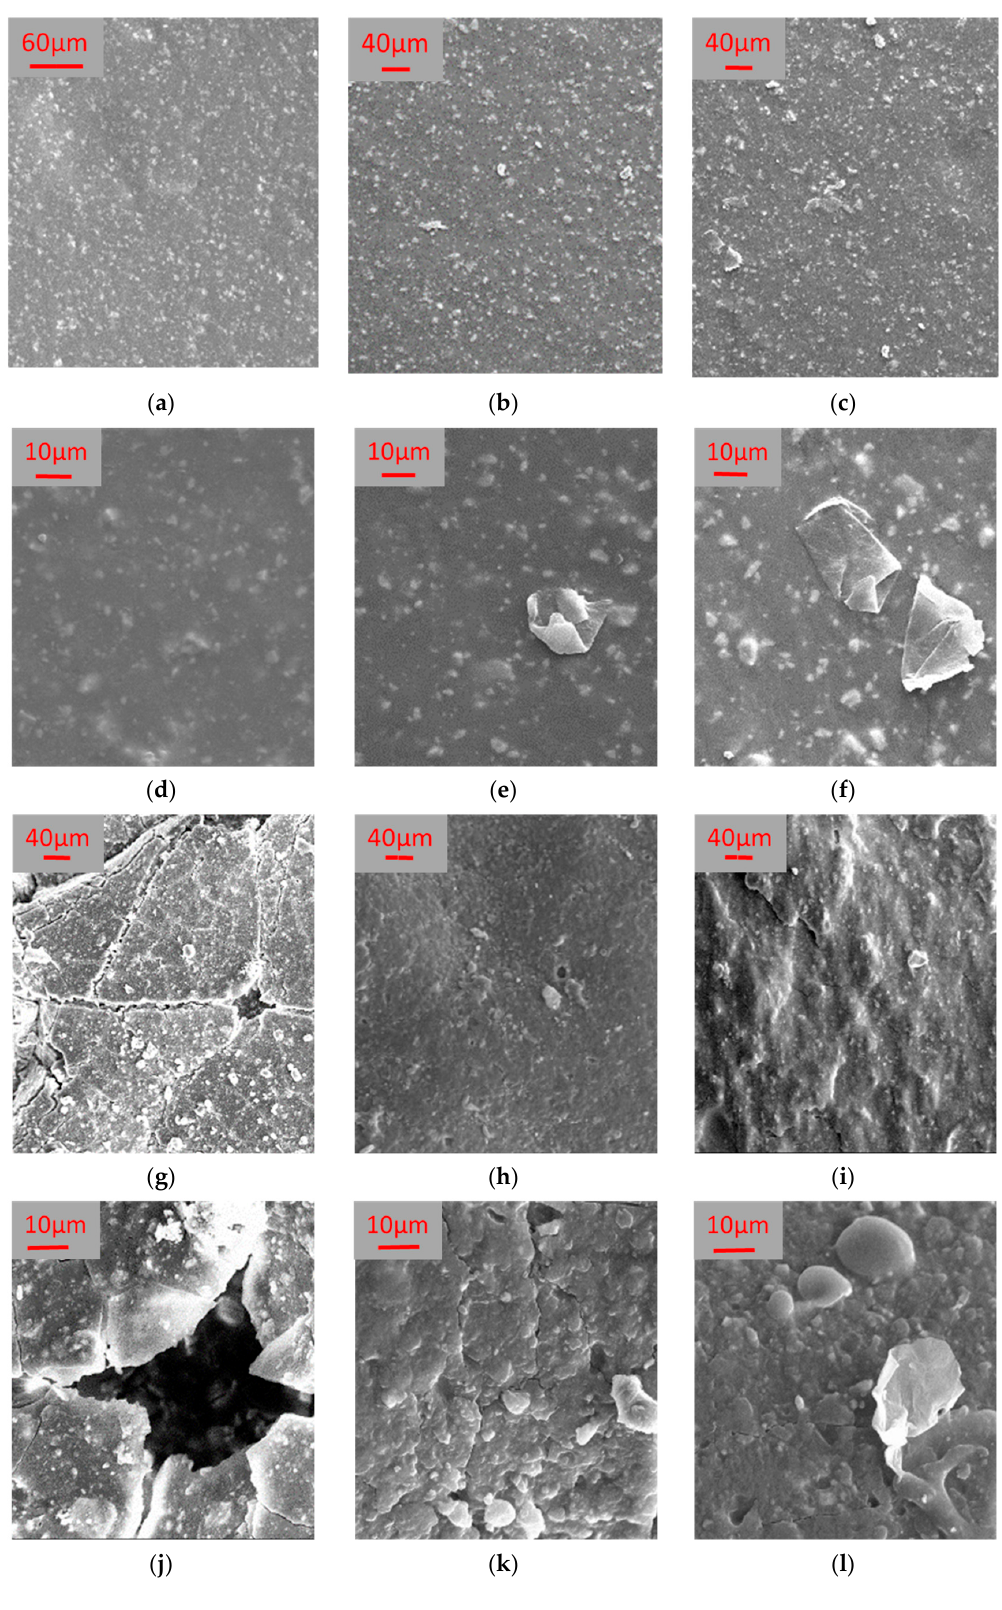
Figure 4. SEM images acquired just after membrane preparation for the ( a – c ) native membrane, the MGLQ, and MGHQ at 500× and ( d – f ) at 2.5k×, respectively; and after ageing treatment for the native membrane, the MGLQ, and MGHQ ( g – i ) at 500× and ( j – l ) at 2.5k×, respectively.